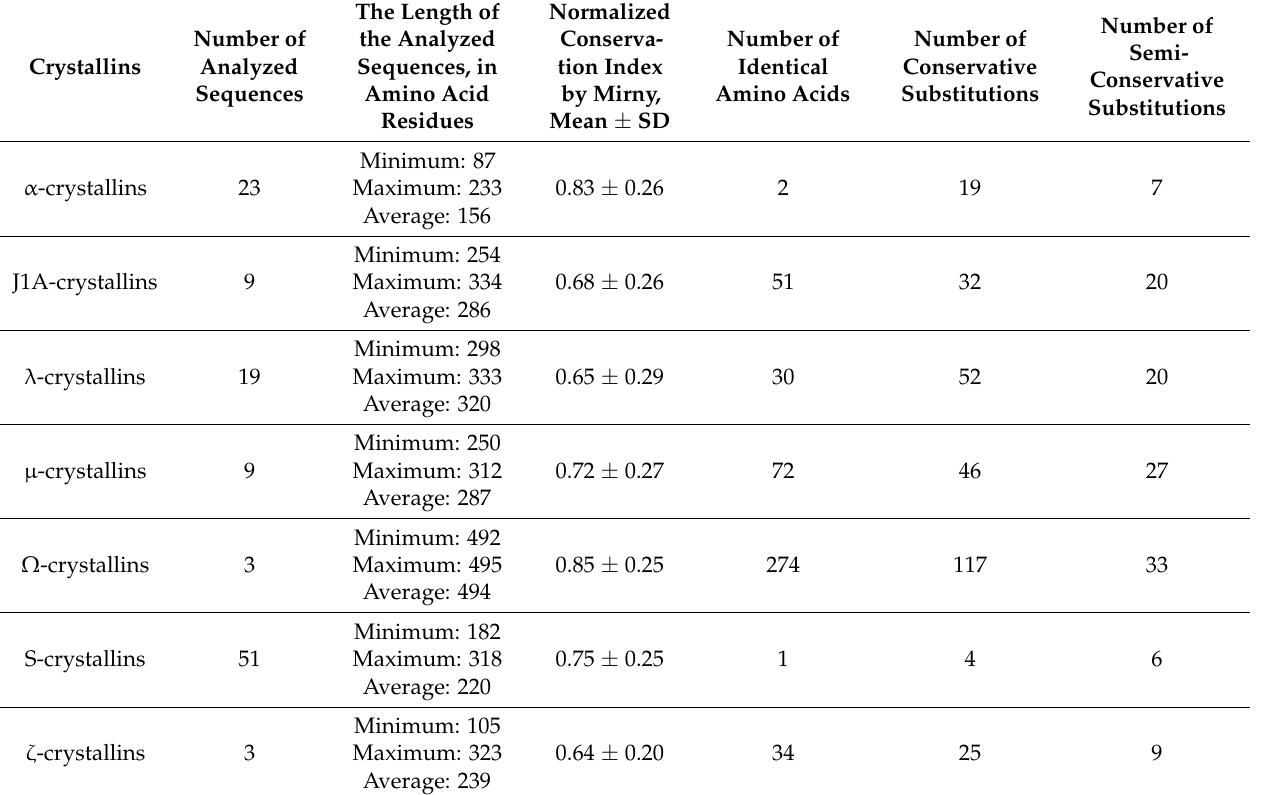
Table 1. Analysis of multiple sequence alignment of crystallins and crystallin-like proteins of